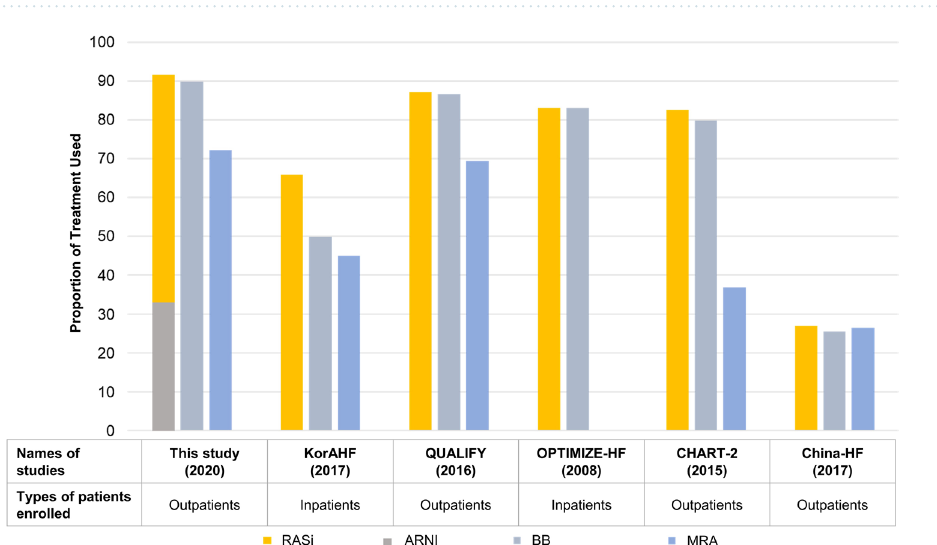
Figure 3. Comparison of SF-36 scores according to physician adherence at baseline and at the 6-month follow-up. MCS, mental component summary; NS, not significant; PCS, physical component summary; SF-36, 36-Item Short Form Survey.